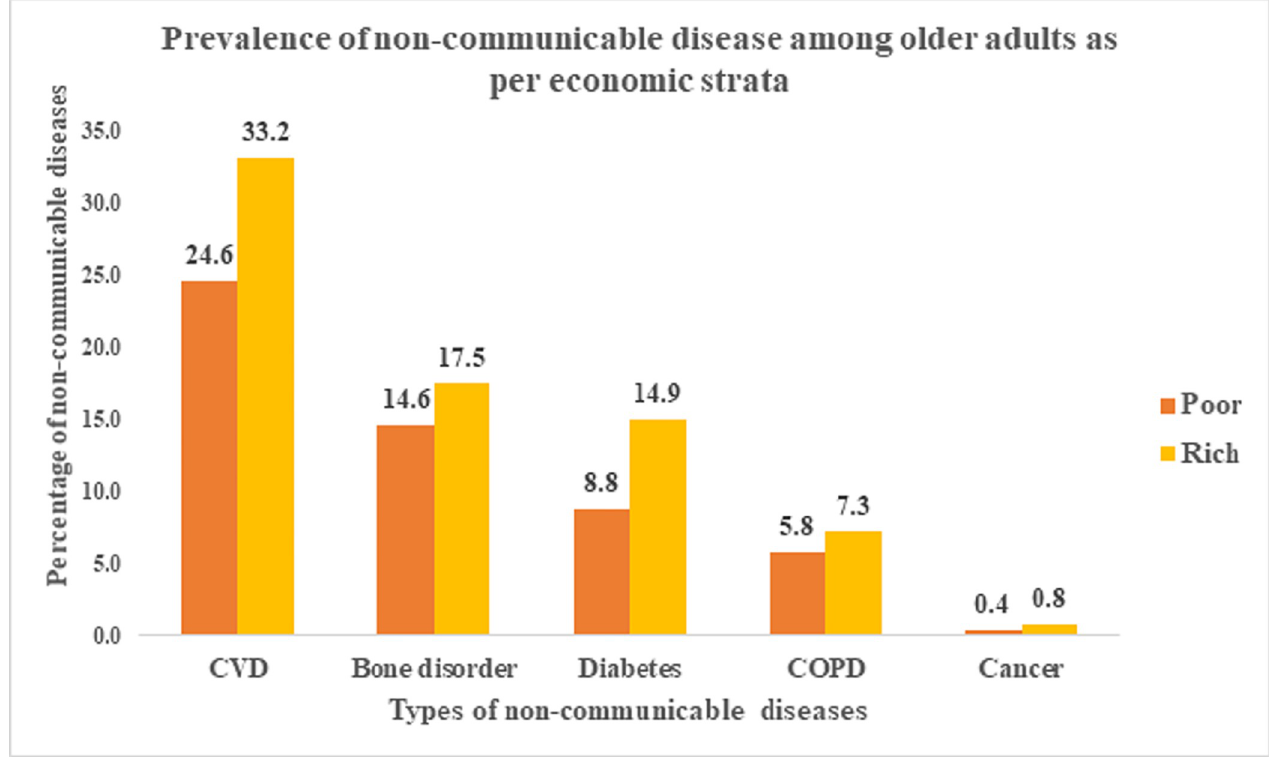
Fig 3. Percentage of non-communicable diseases among older adults as per economic strata. https://doi.org/10.1371/journal.pone.0283385.g003 is—0.043. But for non-communicable disease, the concentration is among socio-economically non-poor strata, where the curve situates under the line of equality. The value of the concen- tration index is 0.094. From the graph it also can be interpreted that the inequality is higher